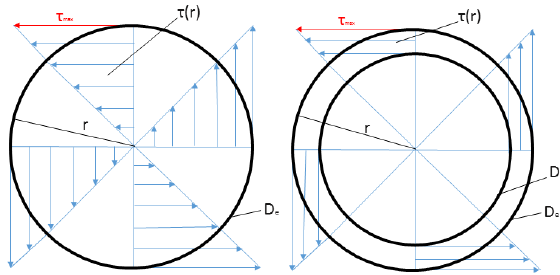
Figure 5. The shearing stress τ distribution in the plane of cross section for ( right ) solid shaft; ( left ) hollow